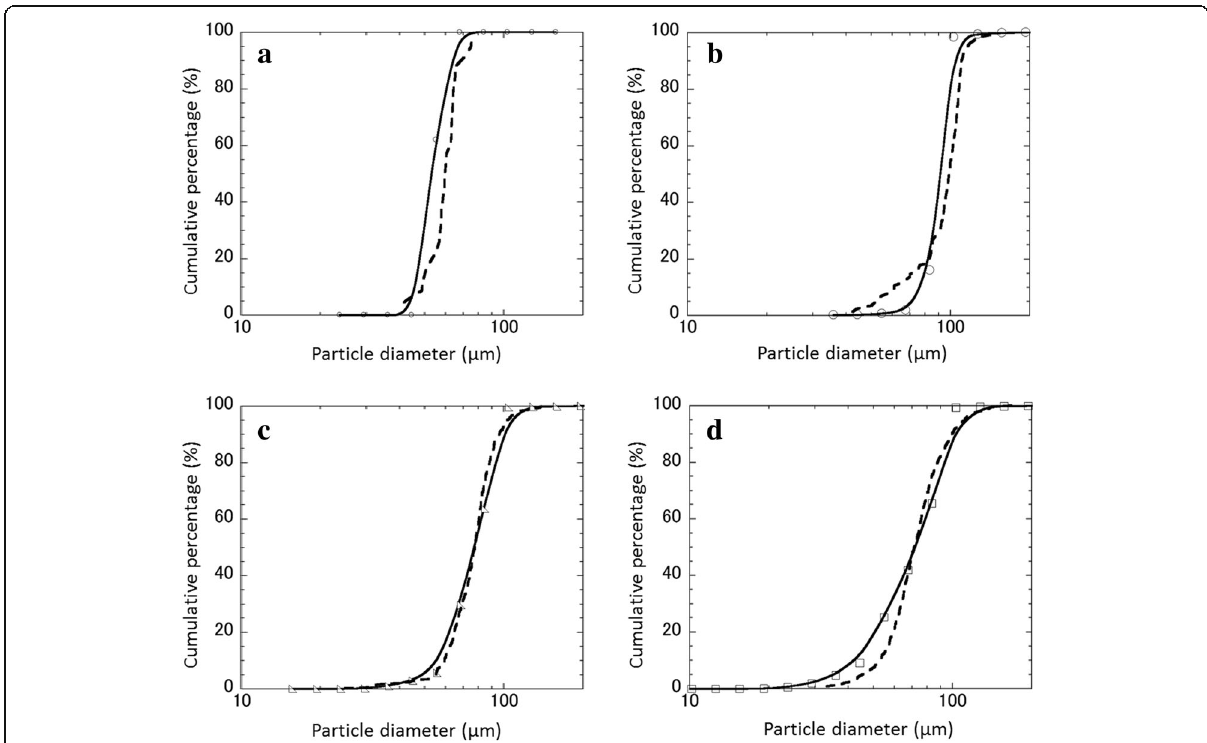
Fig. 1 Particle size distributions. Cumulative volume fractions plotted against the particle diameter. a 50 μ m glass beads, b 100 μ m glass beads, c alumina particles, and d silica sand. Solid and dashed lines are the size distributions determined using a laser diffractometer and optical microscope images, respectively. In the latter, the diameter of the equivalent sphere of the projected area of the microscope image is used